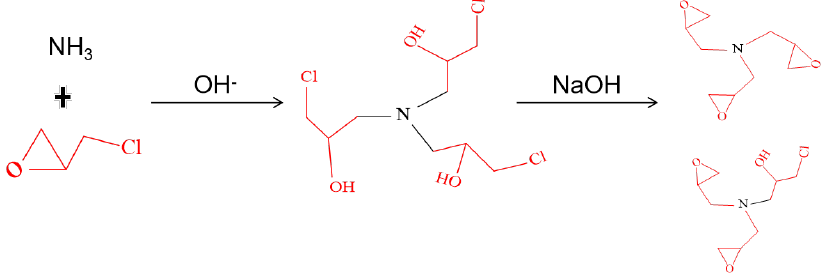
Figure 1. Cross-linking Agent (CA) Synthesis Schematic.